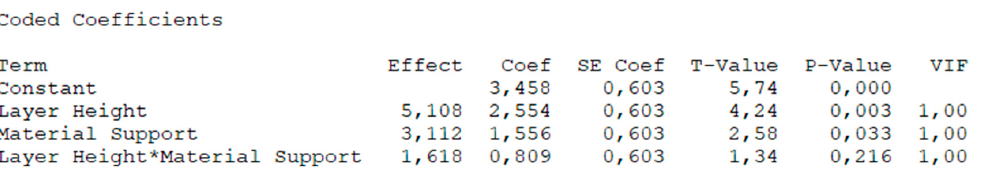
Figure 7. Results of the factorial plan.